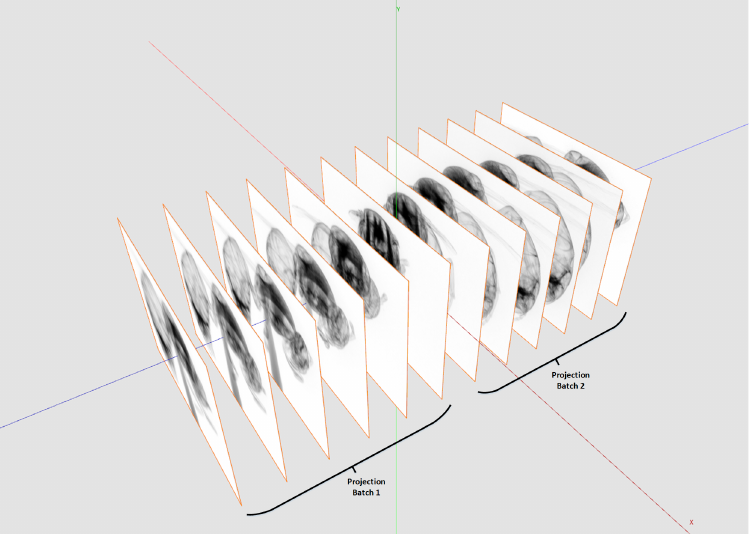
Figure 7. Depending on the available GPU memory and the maximal GPU texture size, the projection stack used for the reconstruction needs to be